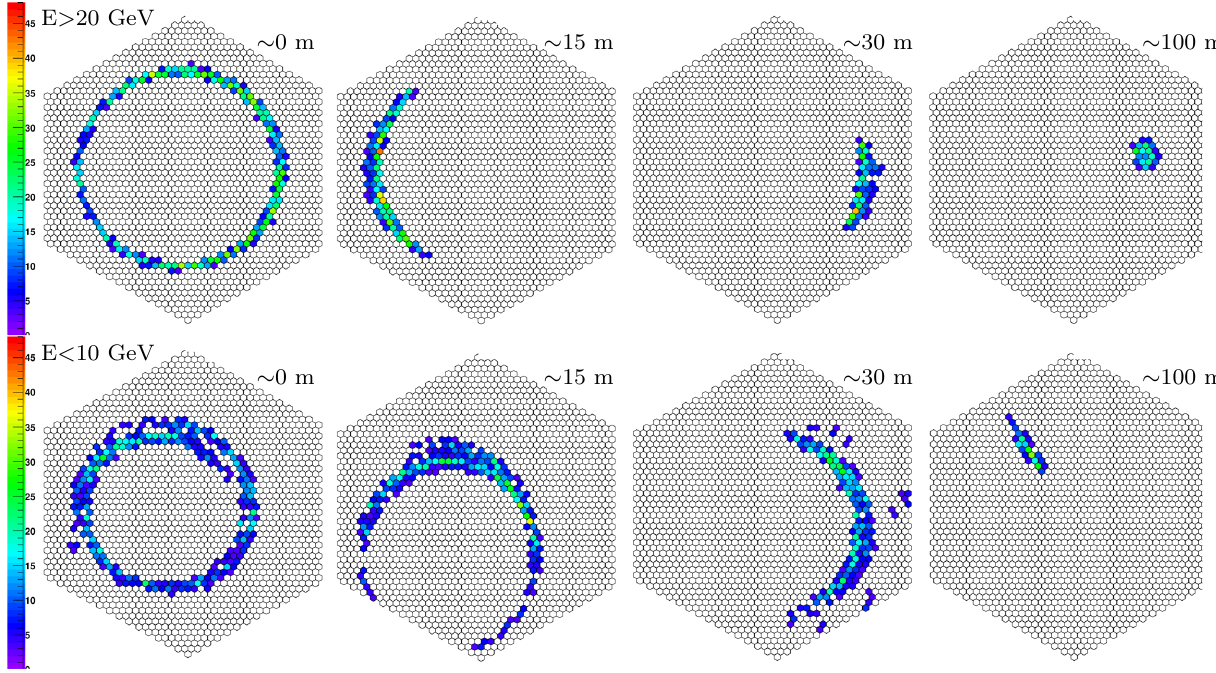
Fig. 1 Example simulated muon images in a 28 m telescope at different energies and impact distances. All simulated muons are produced at 11 km above sea level and are observed at 1835 m with a zenith angle of 20 ◦